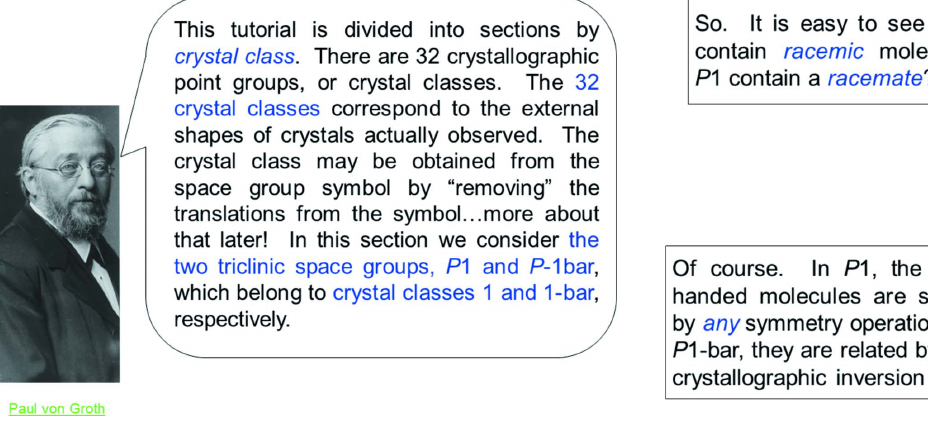
Figure 5 Slide 33, Chapter